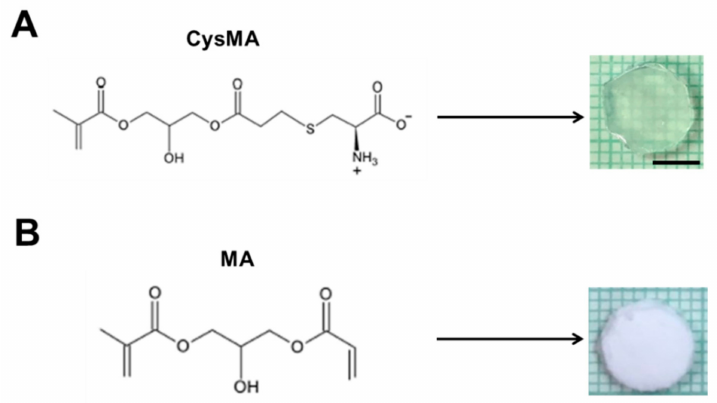
Figure 2. Preparation of hydrogels; 20 µ L of homogenized nanoclay (78.6 mg) in deionized water (1 mL) were added to homogenized ( A ) CysMA or ( B ) MA 1 mL (0.5 M), followed by Poly(ethylene glycol) methacrylate (20 µ L), KPS (5 mg) and TEMED (1 µ L). The mixed solution was then added to the mold, waiting for the end of the reaction. Bar = 0.5